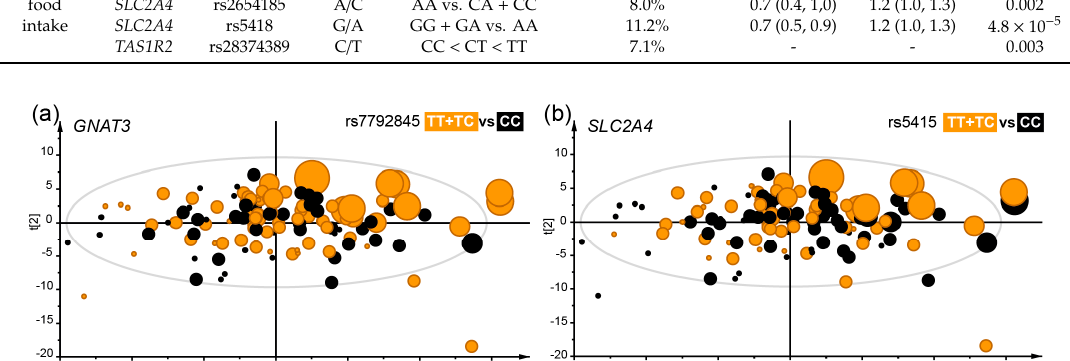
Figure 2. The distribution of genotypes illustrated in scatter plots from multivariate Partial Lest Square (PLS) modelling with TT sweet concentration levels as the dependent variable and various sweet food intake proxies and sweet, sour and bitter foods and tastes as the independent block. The model explained (R 2 ) 55% and predicted (Q 2 ) 7% after validation by the “leave-one out” method. Each dot represents a participant and the size illustrates TT sweet concentration levels. Participants in the GNAT3 rs7792845 TT + TC genotype group ( a ) or the SLC2A4 rs5415 TT + TC genotype group ( b ) both positively associated with TT sweet concentration levels are shown in orange. The scatter plots are score-loading plots where the scores t(1) and t(2) are the new created variables summarizing the x-variables. The oval circle illustrates the tolerance ellipse based on Hotellings of T2, and observations